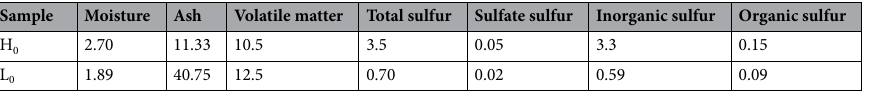
Table 1. Technical parameters of coal samples